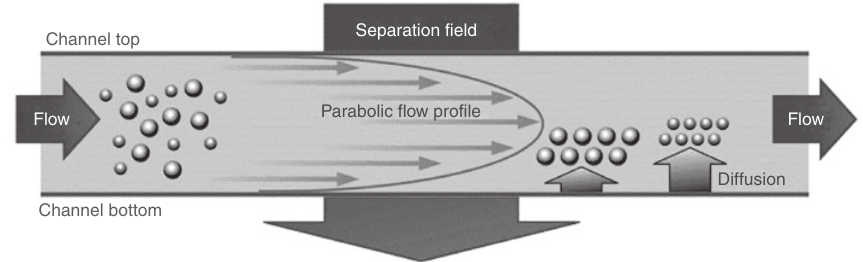
Figure 2: The principle of field-flow fractionation